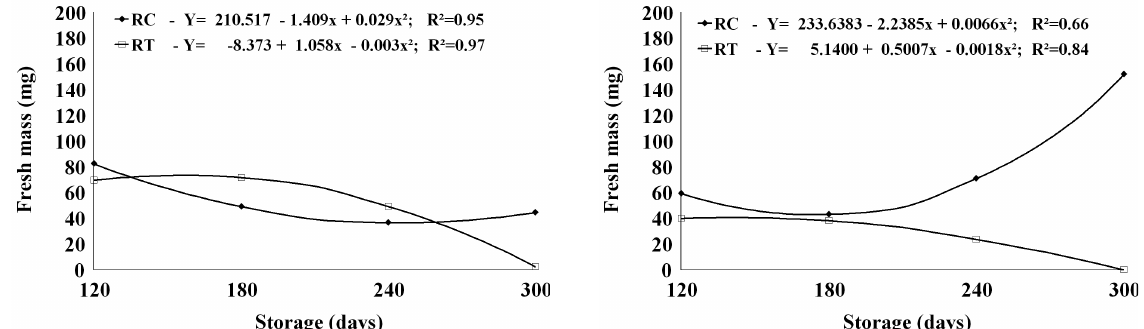
Fig. 7- Fresh mass of Croton urucurana seedlings from the seeds stored at room temperature (RT) and under refrigeration condition (RC) and incubated at 20/30°C (a) and in under greenhouse conditions (b).